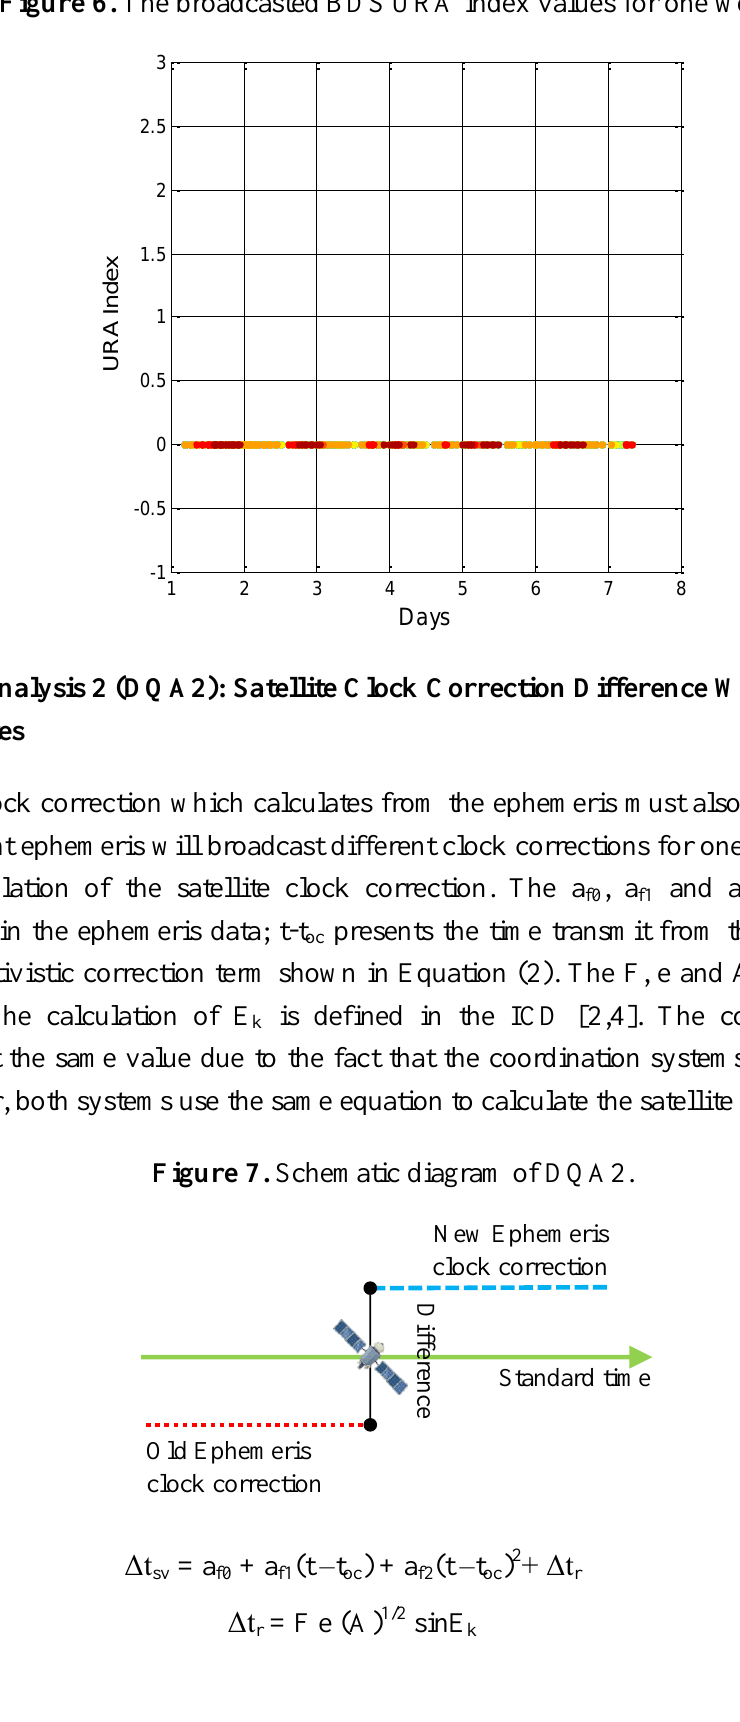
Figure 6. The broadcasted BDS URA index values for one week.